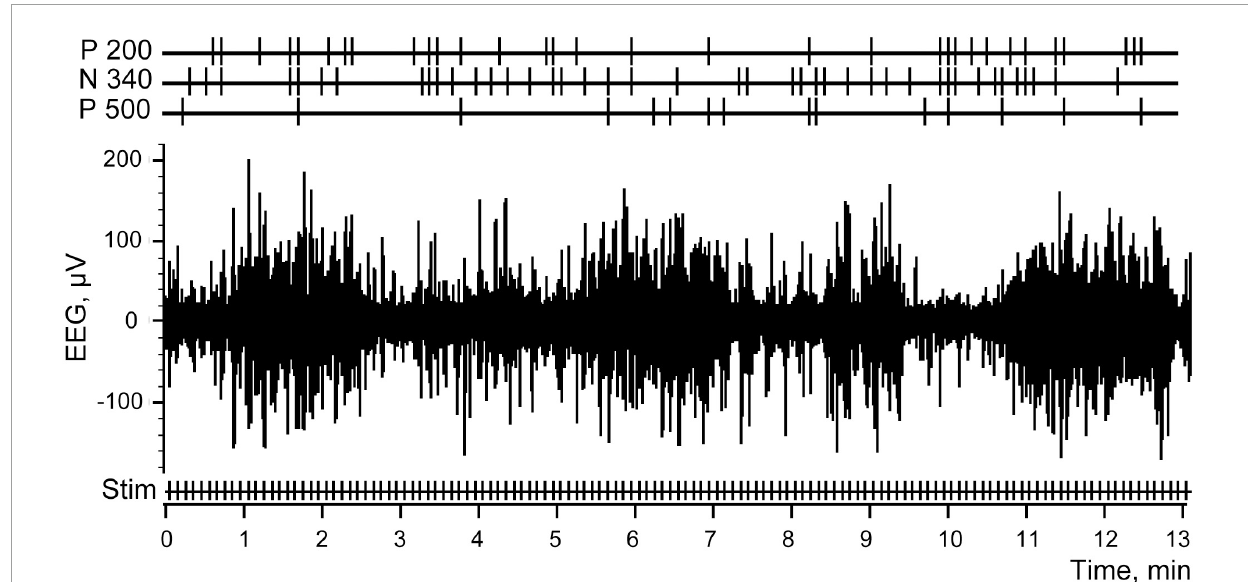
FIGURE7 Electroencephalogram (EEG) and the stimulations of the abdominal viscera. Stim correspond to all electrical stimulations applied, P 200, N 340, and P 500 mark the efficient trials for each of the three components.